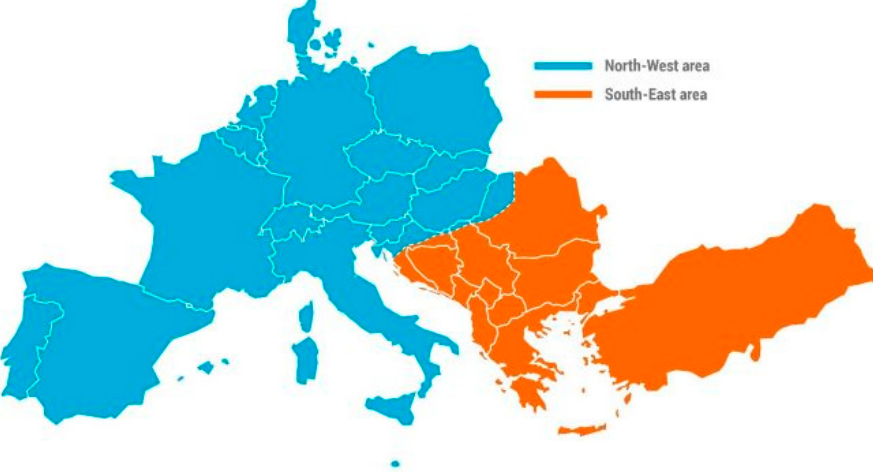
Figure 5. Continental Europe map displaying the two distinct regions on 8 January 2021.